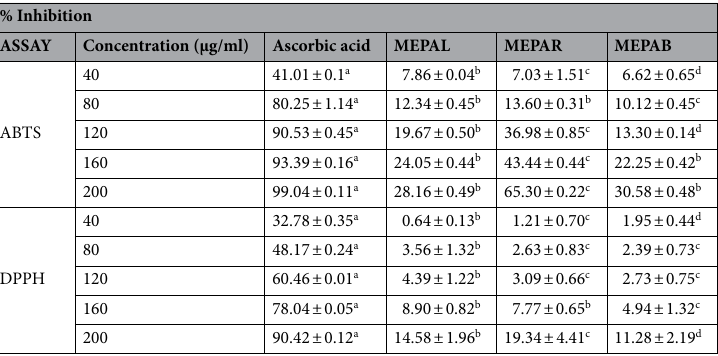
Table 2. ABTS and DPPH scavenging activity of P. americana extracts. Values represent mean ± standard deviation of replicate readings. Values with different superscripts (a,b,c,d) along the same row are significantly different from one another (P < 0.05). Where MEPAL methanol extract of P. americana leave, MEPAR methanol extract of P. americana root, MEPAB methanol extract of P. americana stem bark.